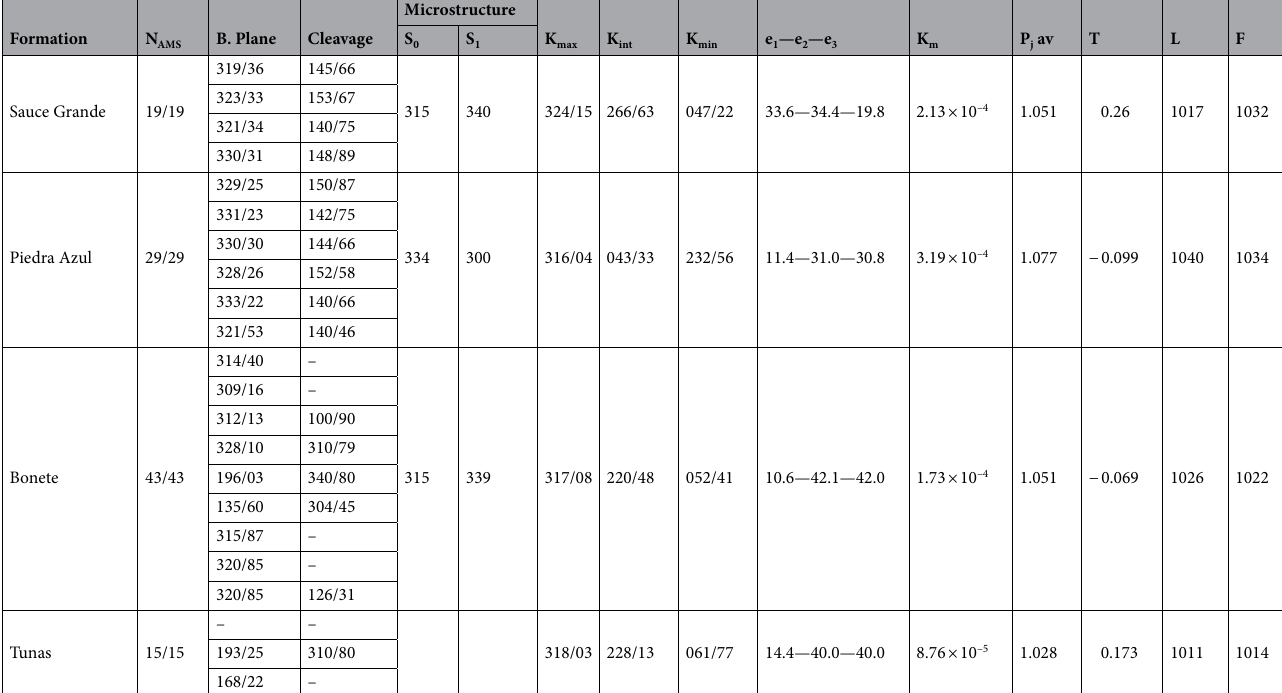
as feldspathic siltstones (Fig. 2C). In the sample of Piedra Azul Formation, from site JP3 (Fig. 2A), a diagenetic foliation related to burial, S 0 , orientated 130° N (NW–SE) is evidenced by oxides, micas and pressure dissolu- tion surfaces. This penetrative plane shows smooth and space cleavage domains, with parallel to anastomosing relationship with microlithons 60 (Fig. 3B). At 120°N (northwest-southeast), there is 50 µm thickness quartz filled microfracture with diffuse limits. Process of pressure dissolution related to foliation planes resulted in sigmoidal geometry of the vein (Fig. 3B), indicating that the vein formed before the foliation. Another weak foliation plane S 1 orientated nearly N–S that it is represented by micas and opaque minerals (Fig. 3C). The sample from site JP6 have a smooth, spaced, parallel to slightly anastomosed foliation, with discrete transition between domains and microlithons, orientated at 120° N. Microlithons are composed by grains of quartz and feldspar that depending of its orientation exhibit flattening, pressure shadows, subgrains and pressure dissolution (Fig. 3D, Table 1). Micas, recrystallized quartz, opaque minerals, and epidote compose the folia. Four samples of the Bonete Formation, located at the sites JB3, JB7, JB8 and JB9 were selected (Fig. 2A). Pet- rographic analysis indicates a good selection with sub-rounded grains. The mineralogical and textural maturity is moderate. The contacts between grains are mainly sutured, with some straight to concave–convex contacts. The average size of the grains is 120 µm, with maximum of 200 µm and minimum of 30 µm. The grains are quartz, potassic feldspar, plagioclase and muscovite, with minor lithic fragments. The matrix is composed of quartz, illite, chlorite and montmorillonite and the cement by opaque minerals, carbonate and diagenetic epidote. Diagenetic chlorite and illite are present. Samples classify as feldspathic sandstones (Fig. 2C). In some sectors there are also wackes, with poor sorting, matrix supported grains and similar composition than sandstones. The sample of Bonete Formation, from the site JB3 (Fig. 2), have a primary foliation S 0 orientated at 125° N (NW–SE). It is evi- denced by flattening of the quartz and feldspar grains in microlithons, mica and opaque minerals that constitutes cleavage domains (Fig. 4A). Foliation observed is spaced, between rough and smooth, and sub-parallel. Transition between the cleavage domains and microlithons is discrete 60 (Fig. 4A). Pressure shadows and subgrains in quartz grains and feldspar (plagioclase) grains are present (Fig. 4B). There is a second foliation S 1 , 150° N (NW–SE), defined by planes of fluid migration and opaque minerals and micas presence (Fig. 4A, Table 1). The foliation on sample from the site JB7 (S 0 ) is evidenced by grains flattening, mica and opaque minerals orientated 130° N (NE–SW) (Table 1). Foliation is spaced, between rough and smooth and sub-parallel. Transition between cleavage